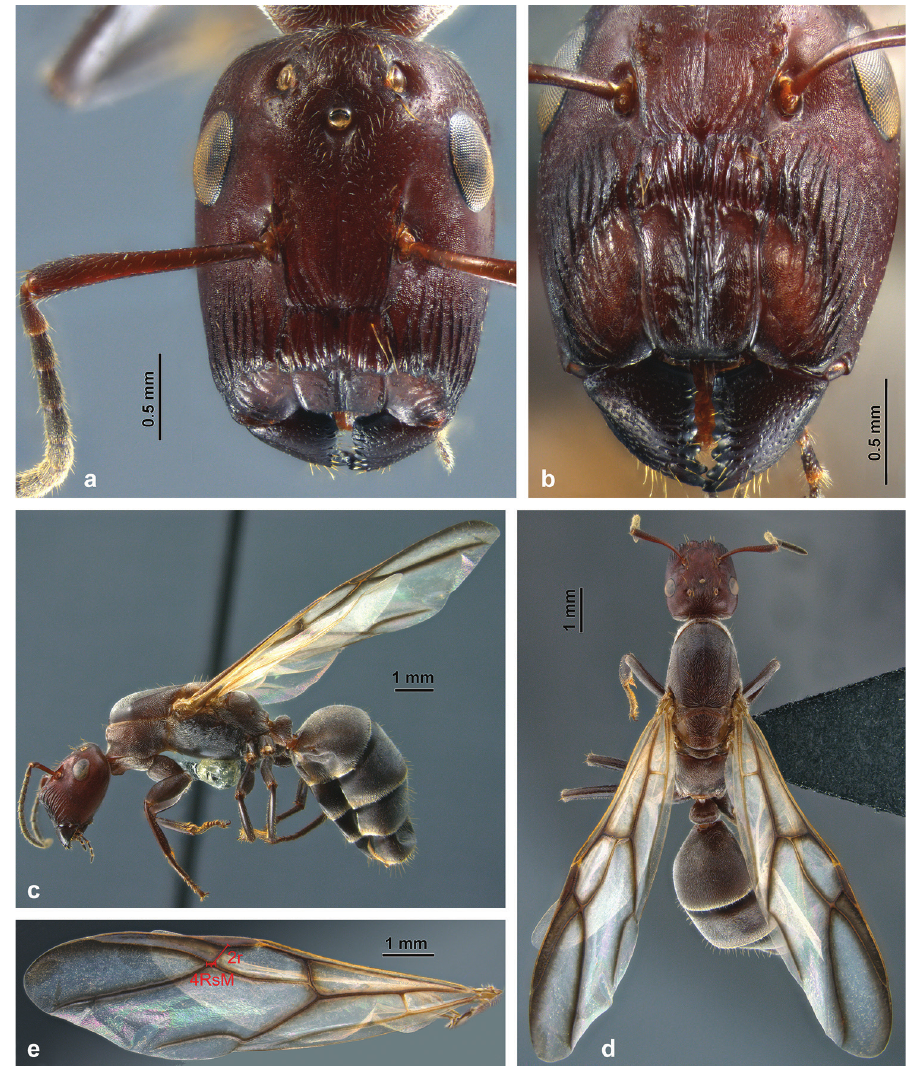
Figure 5. Habitus of C. explodens sp. n., paratype, alate gyne; a full-face view b frontal shield c lateral d dorsal view e forewing with indicated measurements 2r and